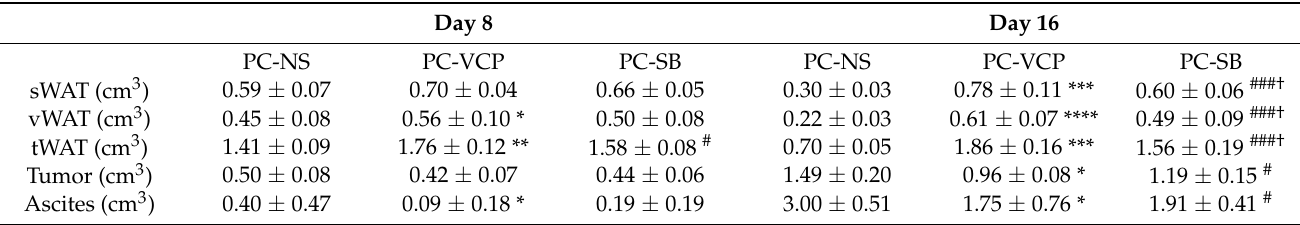
Table 1. MRI-measured volumes of adipose tissue, tumors and ascites.